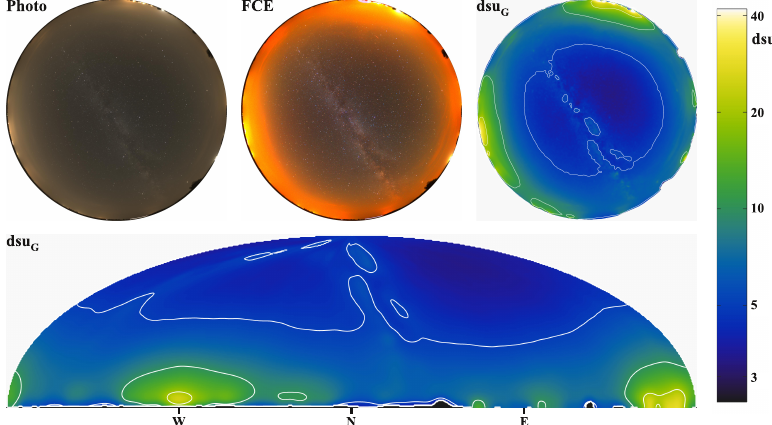
Figure 1. Representations of digital camera measurements after DiCaLum processing. The top left image shows the original photographic montage of the upper hemisphere. FCE displays the same image with false colour enhancement, which amplifies the differences compared to a normal, natural sky. The Green channel radiance in the dsu unit is presented in the standard fish-eye projection and Hammer-Aitoff